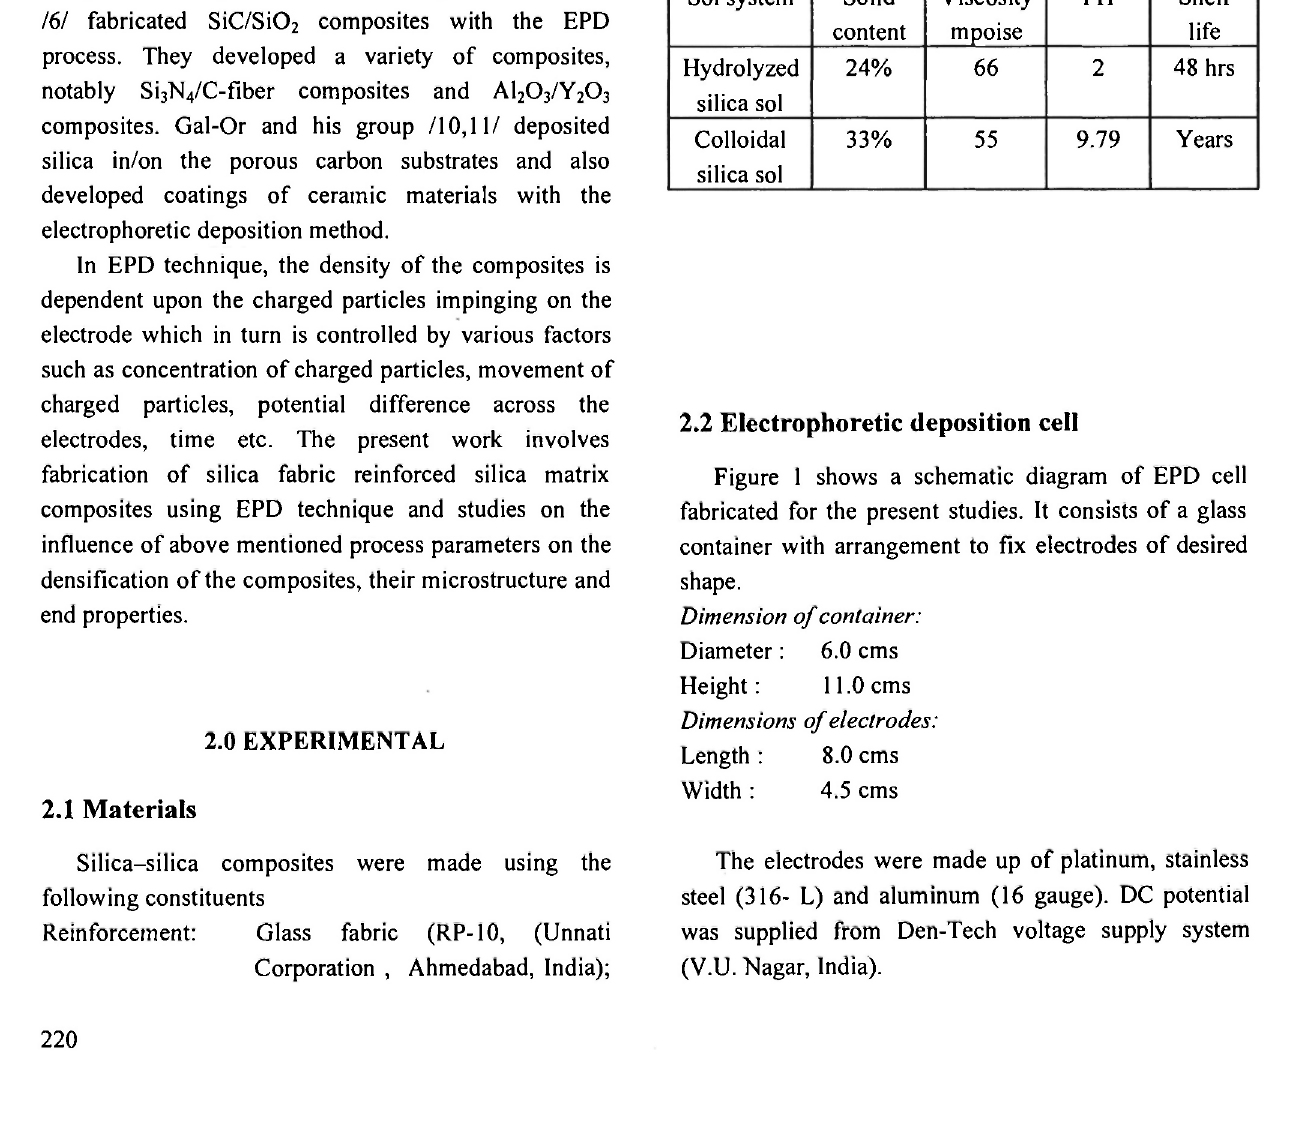
Characteristics of sol